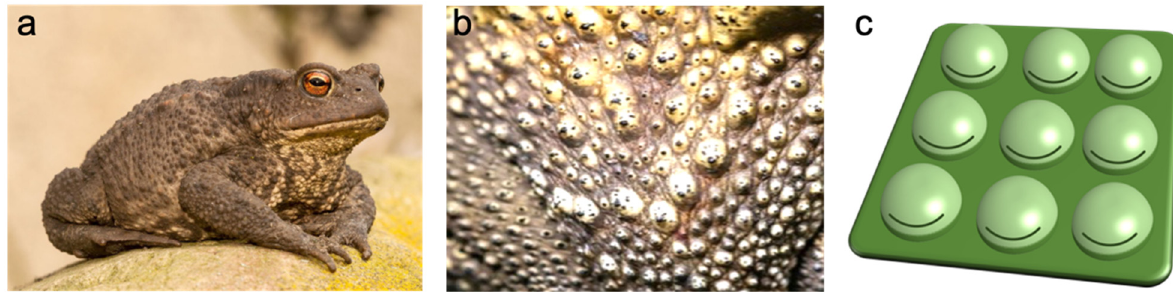
Figure 1. ( a ) Picture of a toad. ( b ) Warty texture of a toad’s skin. ( c ) Schematic of bioinspired pressure sensor arrays with spherical bumps. The black lines are strain gauges.